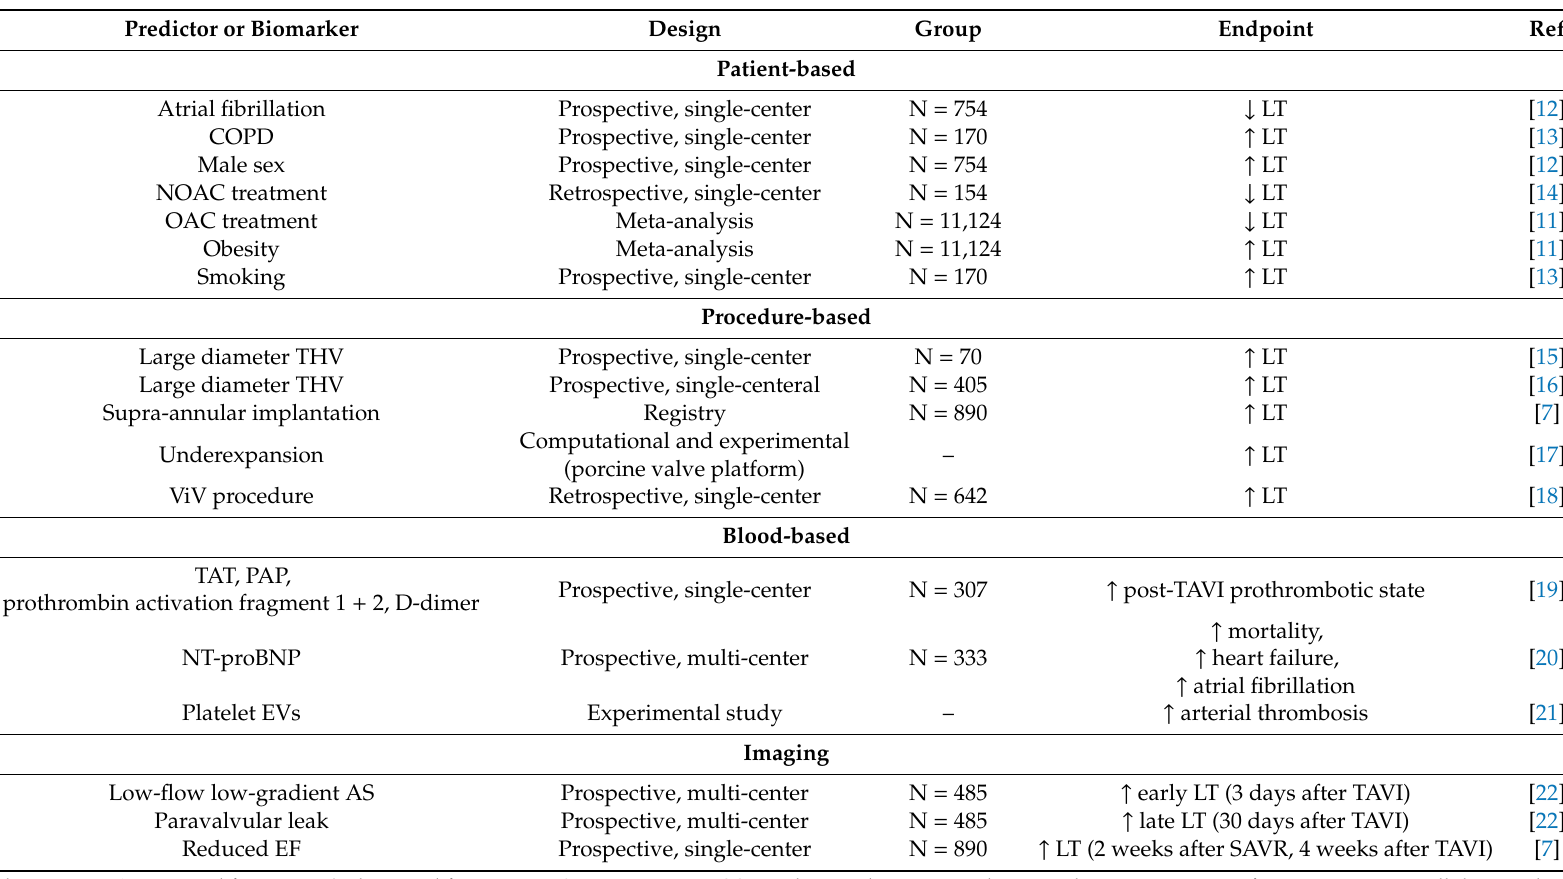
Table 1. Potential predictors and biomarkers of leaflet thrombosis (LT) after transcatheter aortic valve implantation. All endpoints refer to sublinical